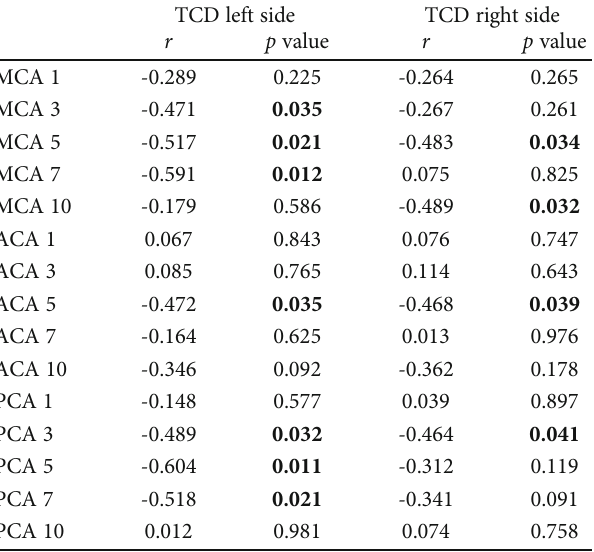
Table 4: Correlation between TCD fi ndings and cognitive impairment